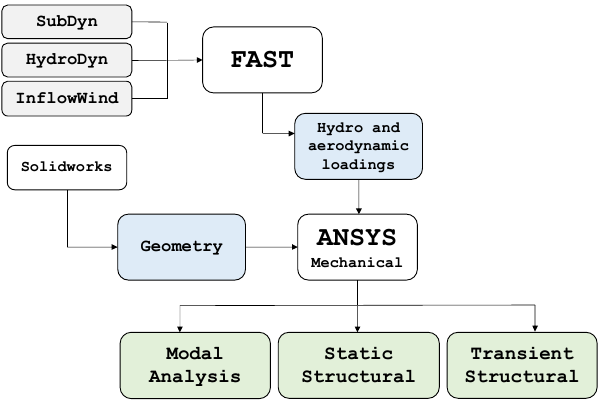
Figure 2. Flowchart of the interaction between FAST and ANSYS used during the present research.